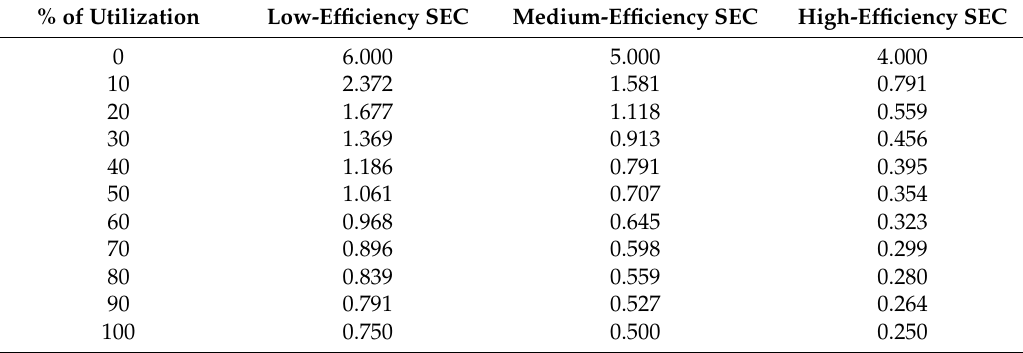
Table 1. Estimated electricity consumption in kWh/kg for different values of machine efficiency and % of utilization.